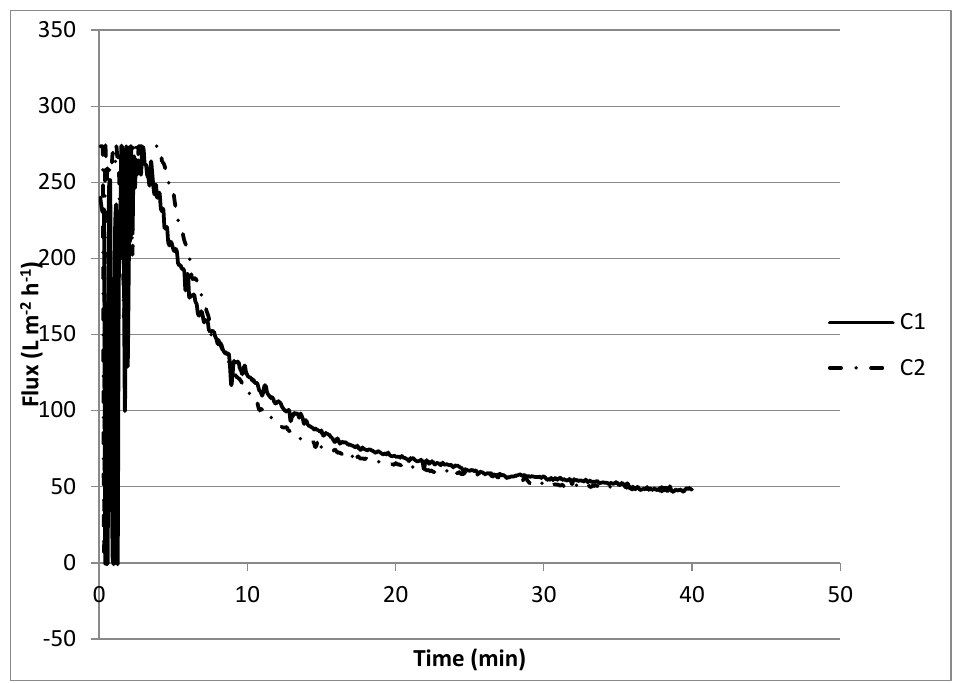
Figure 6. Membrane performance for the effect of sodium alginate, calcium, and softening agent on fouling.